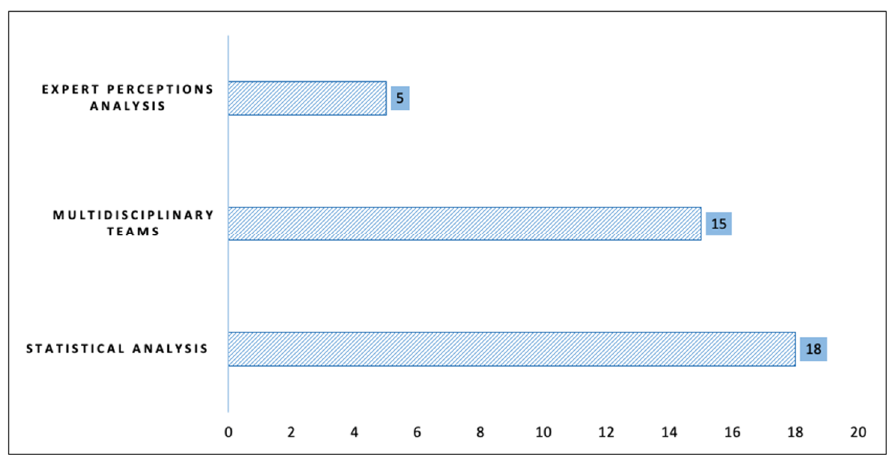
Figure 2. Methodological design.